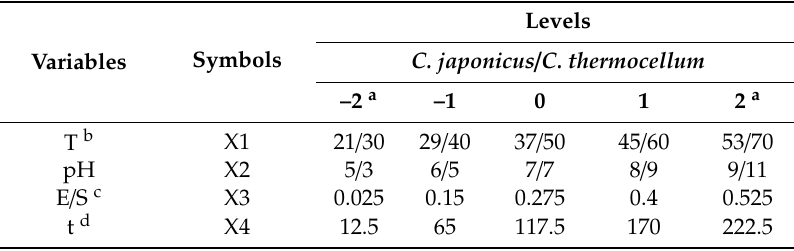
Table 1. Ranks of the levels designed for the experimental design (CCD). The levels of T and pH were established according to the technical data of enzyme stability from the manufacturer Megazyme.